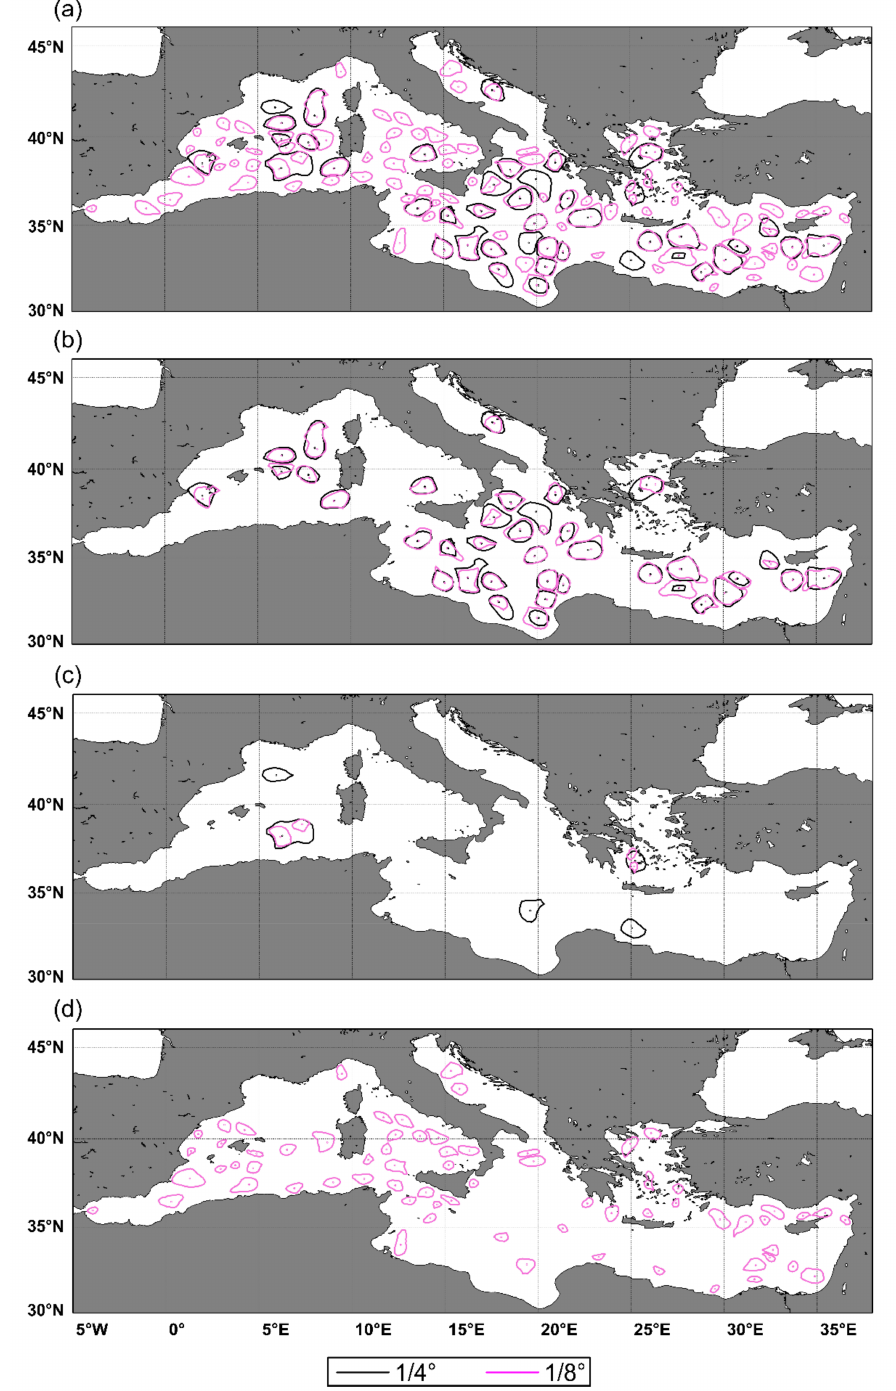
Figure 7. Visualization of eddies for four matching situations from two different resolution data sets in the Mediterranean Sea. The black lines represent eddy effect contours identified using the 1/4 ◦ data, and the magenta lines represent eddy effect contours identified using the 1/8 ◦ data. ( a ) represents all eddies identified under 1/4 ◦ and 1/8 ◦ all-sat data, ( b ) represents Situation A, ( c ) represents Situation B and C, and ( d ) represents Situation D. (See Section 2.2.3 for a description of the four